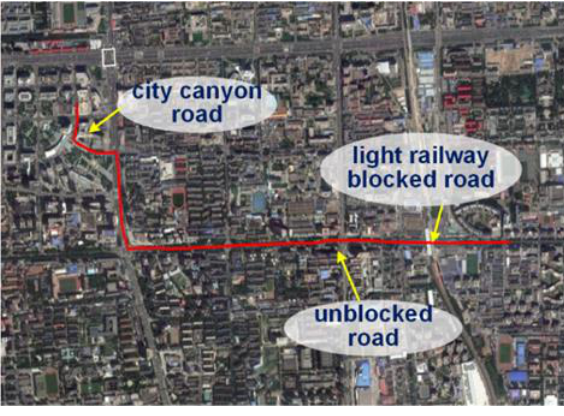
Figure 13. Road test routes.